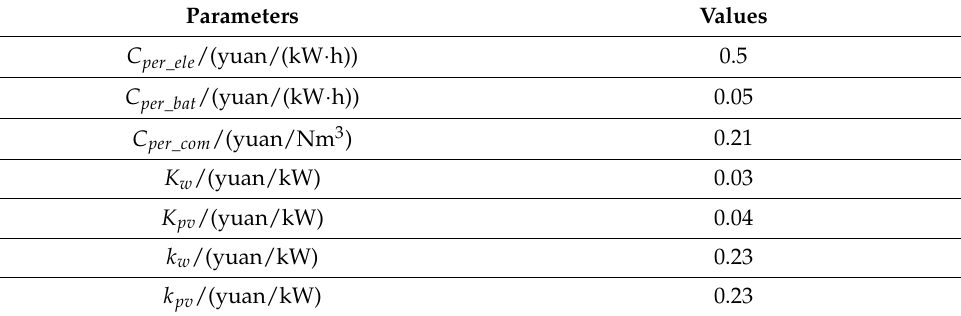
Figure 3. Curve of hydrogen demand in system.